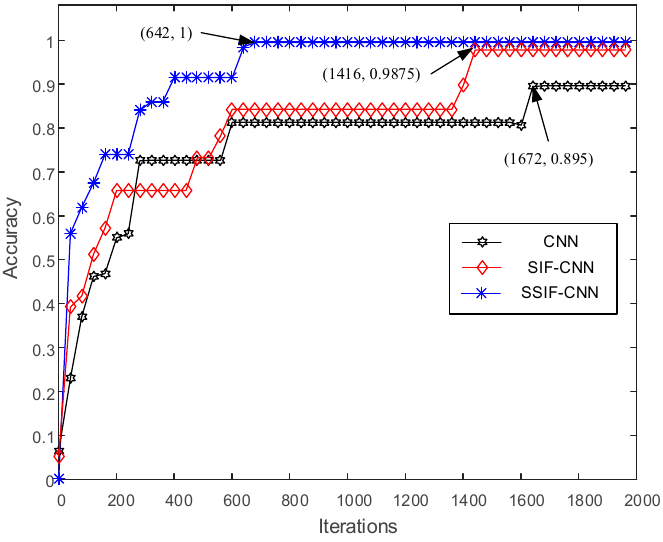
Figure 6. The effect of training sample size on: ( a ) the training accuracy ( b ) time to process one sample.